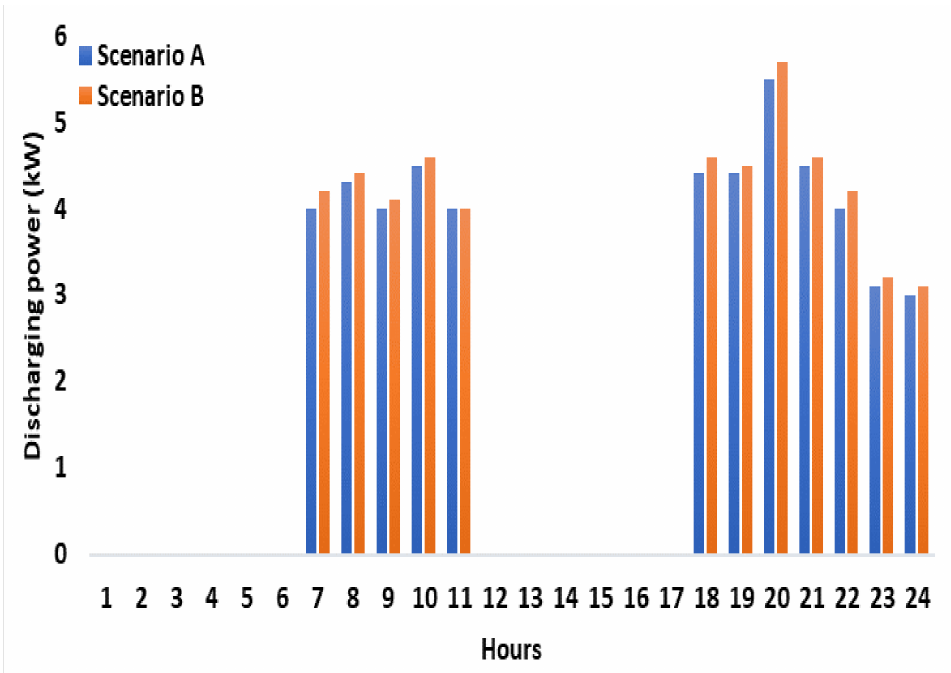
Figure 10. Energy storage unit discharging